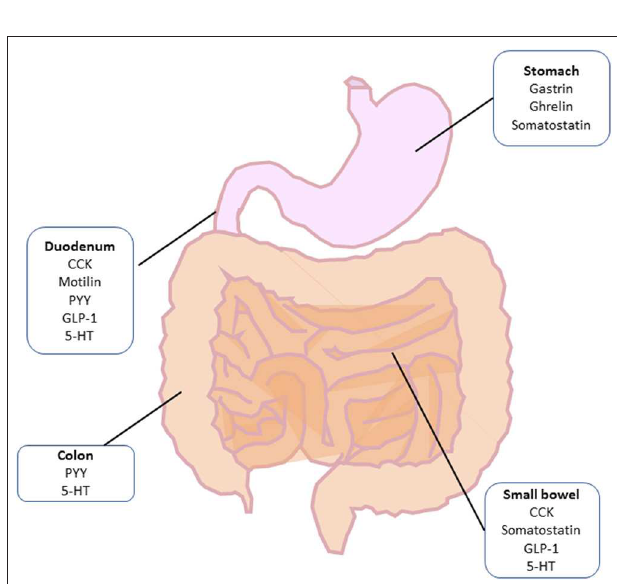
FIGURE 2 | Overview of gastrointestinal peptides and their site of release.